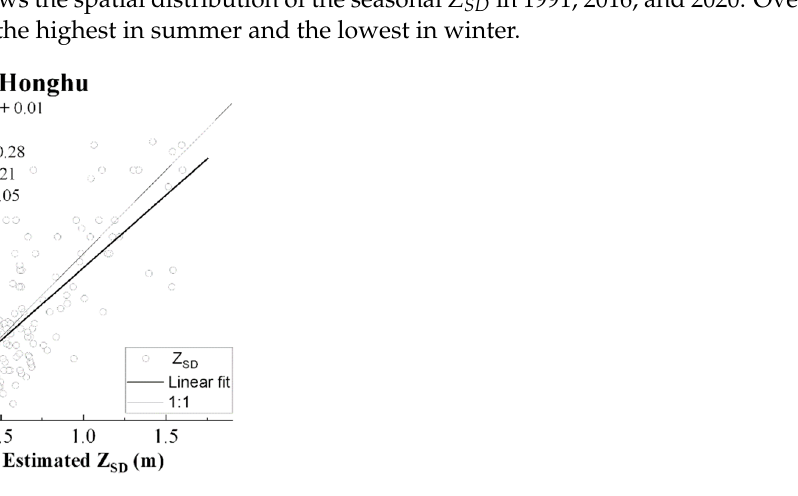
Figure 6. Scatter plots of Landsat-estimated Z SD and in situ-measured Z SD for QAA_Honghu. The field data were gathered ±1–7 days of Landsat satellite overpass.